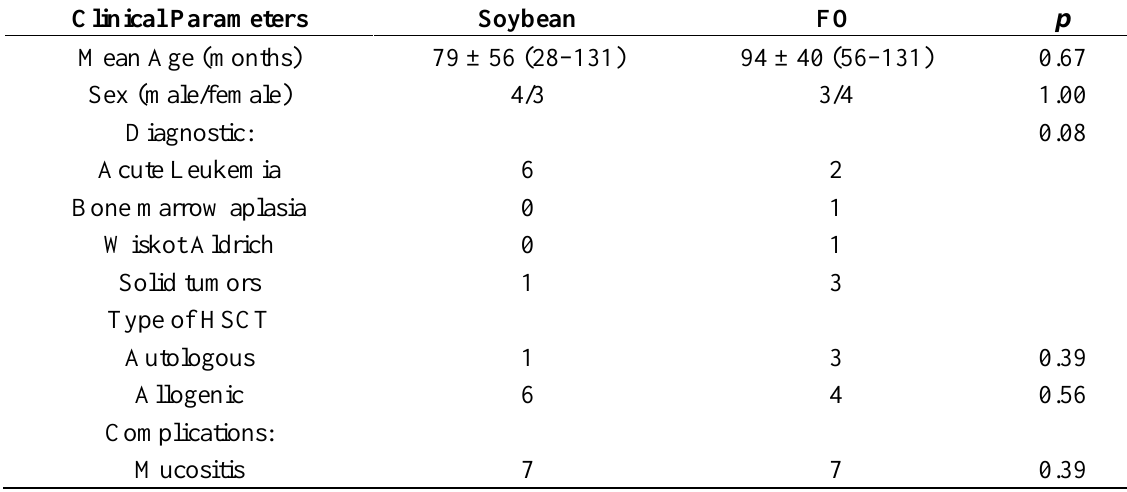
Table 1. Demographic and clinical characteristics of 14 children undergoing hematopoietic stem cell transplantation, with parenteral nutrition with two different lipid emulsions based on soybean and fish oil-containing